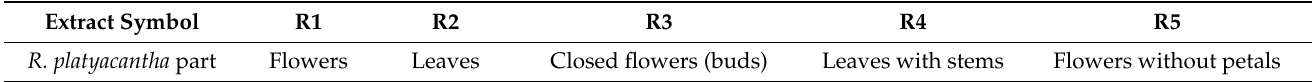
Table 7. Extracts prepared from various parts of Rosa platyacantha Schrenk. Extract Symbol R1